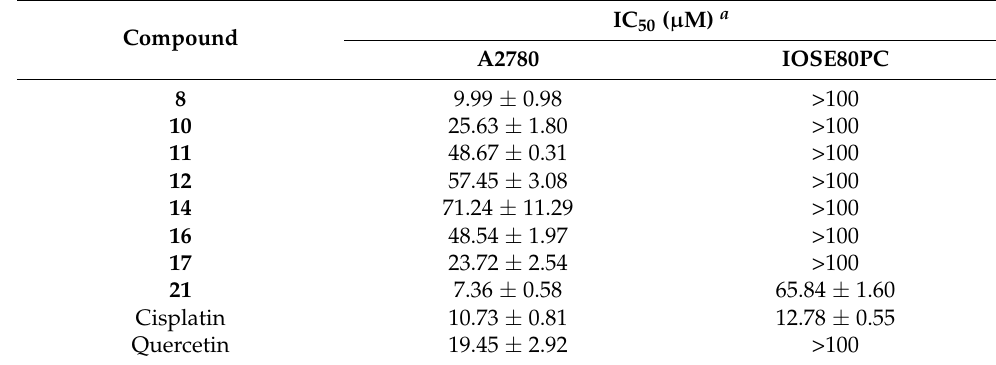
Table 3. The cytotoxicity of compounds 1 − 22 isolated from Pueraria Flos against human ovarian cell lines A2780 and